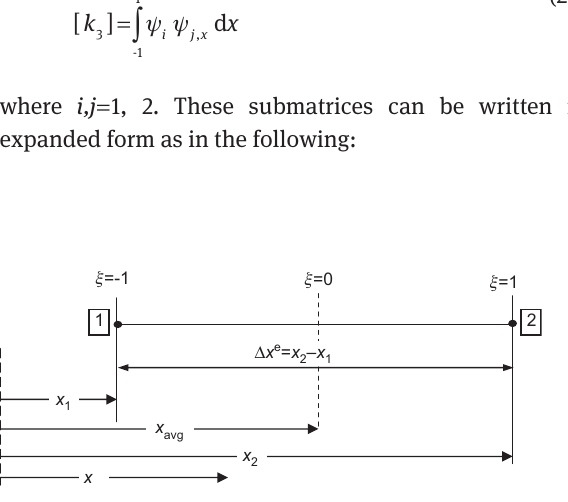
Figure 2 Coordinate system for shape